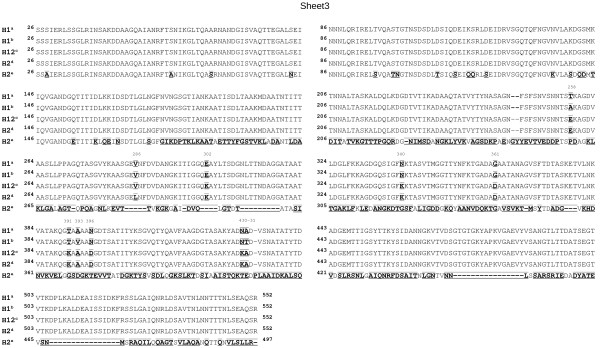
Multiple-sequence alignment of flagellin amino acid sequences representing serogroups H1, H2 and H12 of E. coli using Clustal W. The amino acid sequence of H1a was obtained in this study [GenBank: KC753181]. The amino acid sequences of serogroups H1b, H12c,H2d and H2e were retrieved from NCBI protein database [GenBank: ADR27342, AAQ22679, AAD28525 and BAI30971, respectively]. Two very distinctive H2 flagellin sequences were included in the alignment (H2d: common H2 sequence; H2e: peculiar H2 sequence obtained from E74/68). A dash (‘-’) denotes a gap in the alignment. Amino acid sequence differences are indicated in bold letters. Numbers indicate the various amino acid sequence positions.